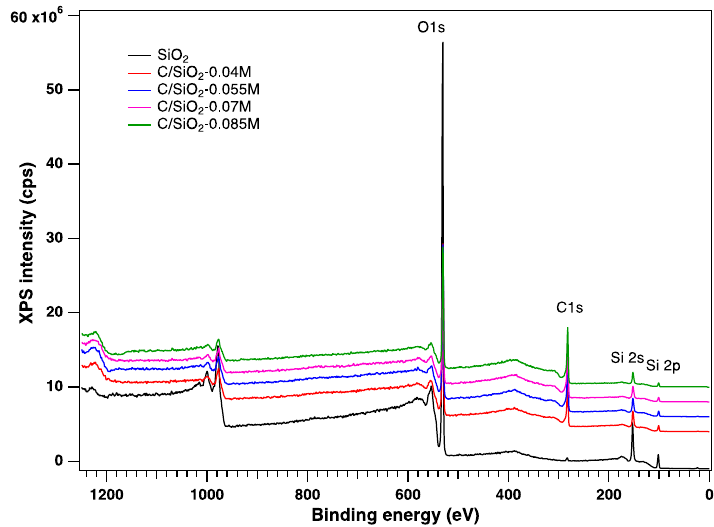
Figure 2. General XPS spectra of the studied samples.